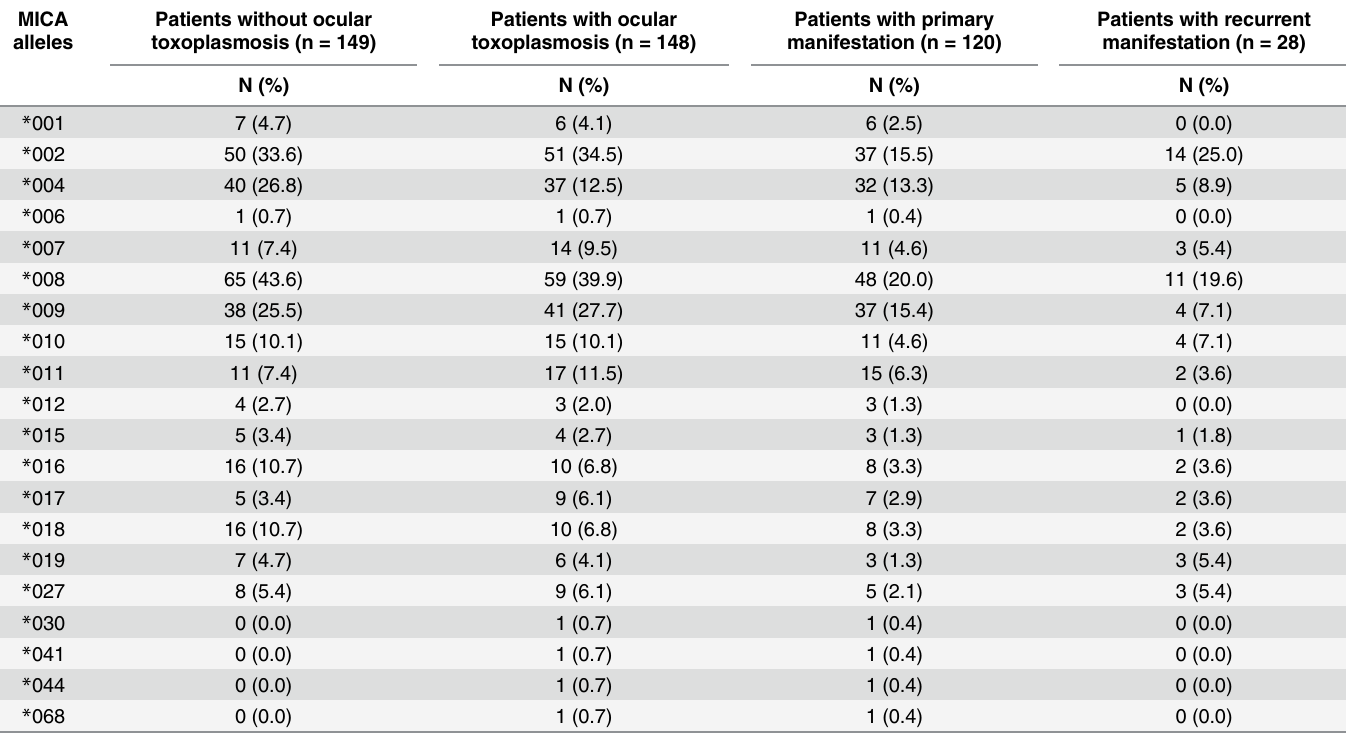
Table 2. Distribution of MICA alleles in patients with and without ocular toxoplasmosis and its manifestation as primary or recurrent MICA Patients without ocular alleles toxoplasmosis (n = 149)